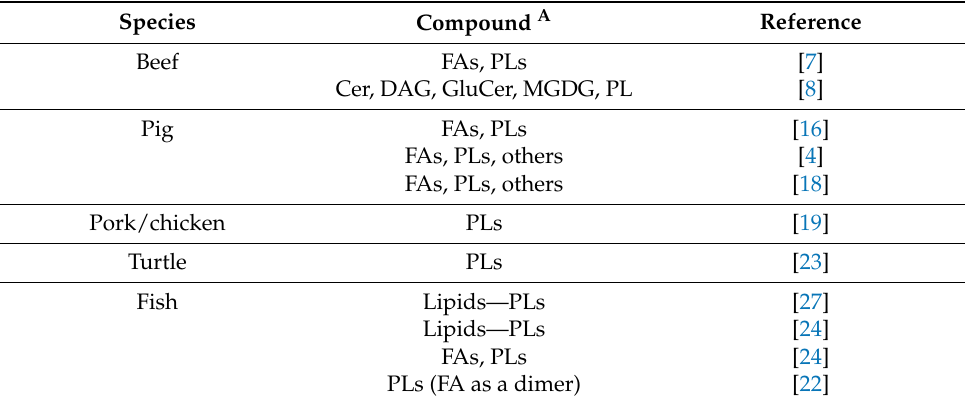
Table 1. Chemical species identification in the application of REIMS to animal tissue.